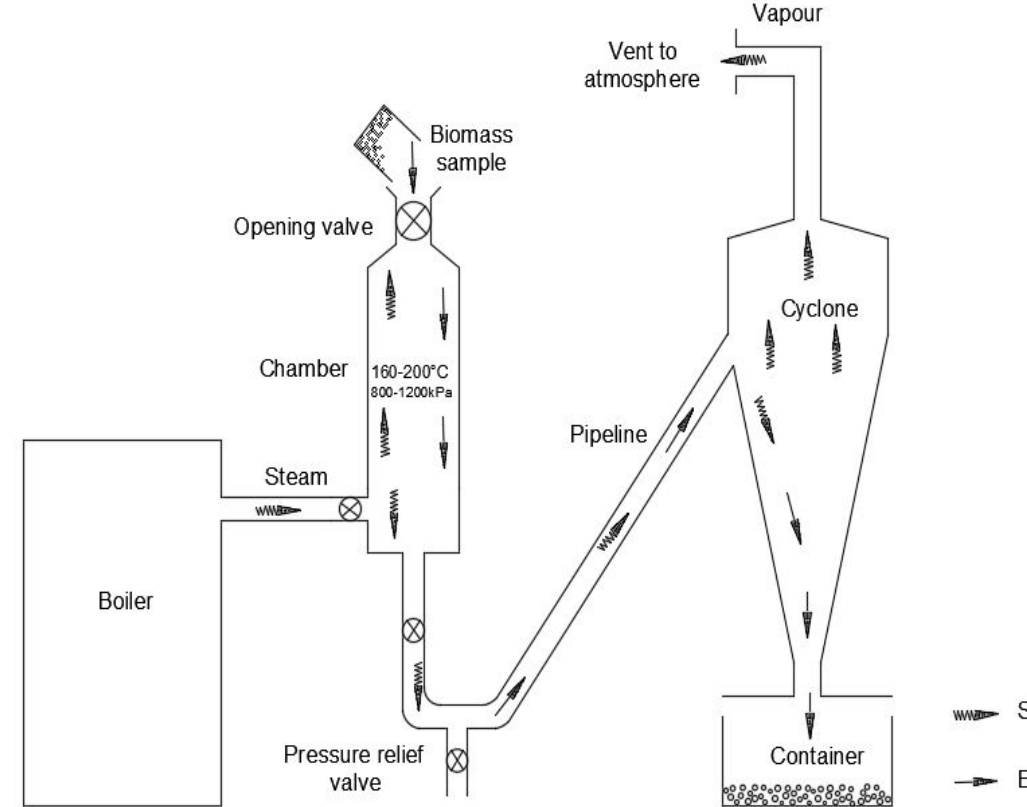
Figure 1. Schematic diagram of the steam explosion system used in the experiments.